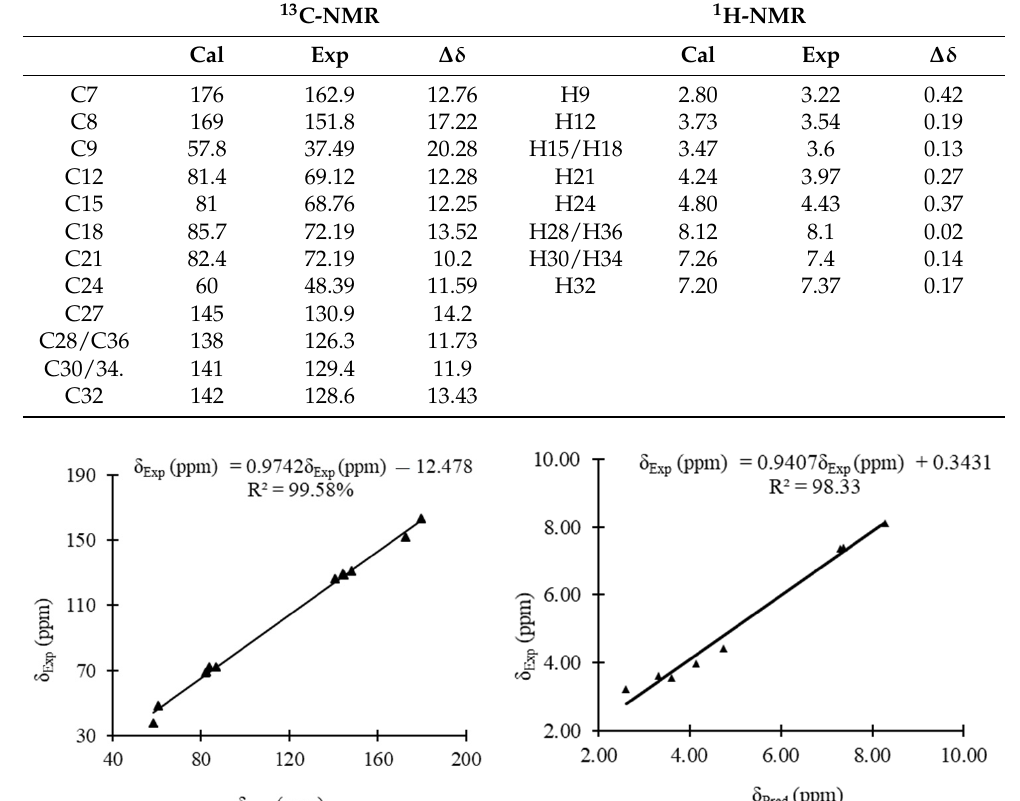
Table 2. Experimental and predicted 13 C and 1 H NMR chemical shifts for 3 .